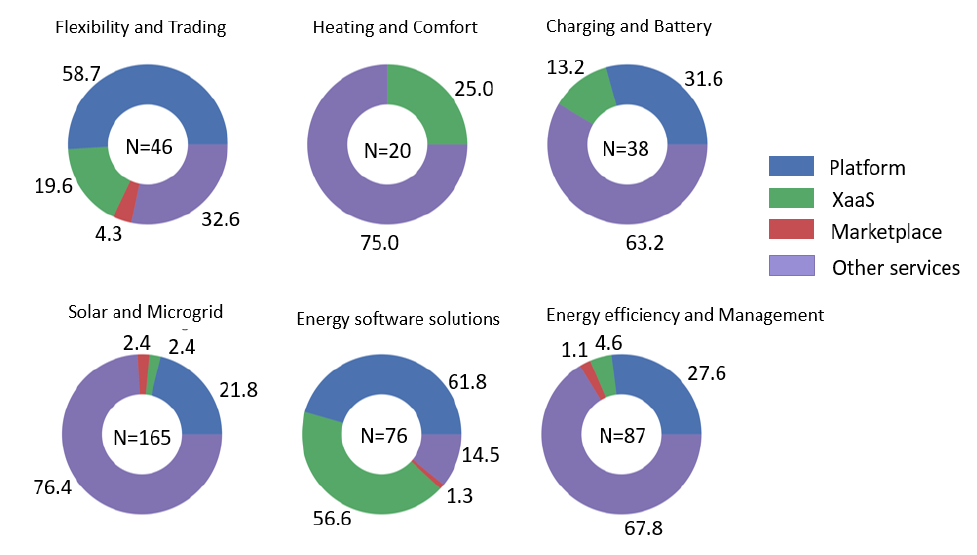
Figure 6. Distribution of platforms, XaaS, marketplace, and other services in energy service categories in percentage (N = Number of